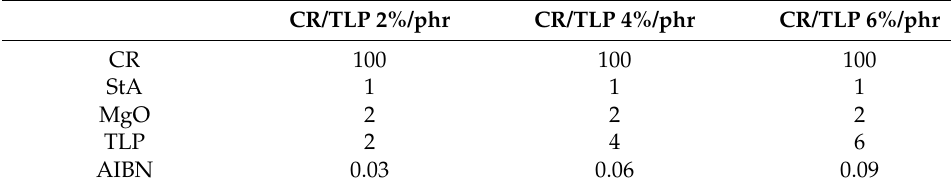
Table 1. Formulation of CR/TLP blends.